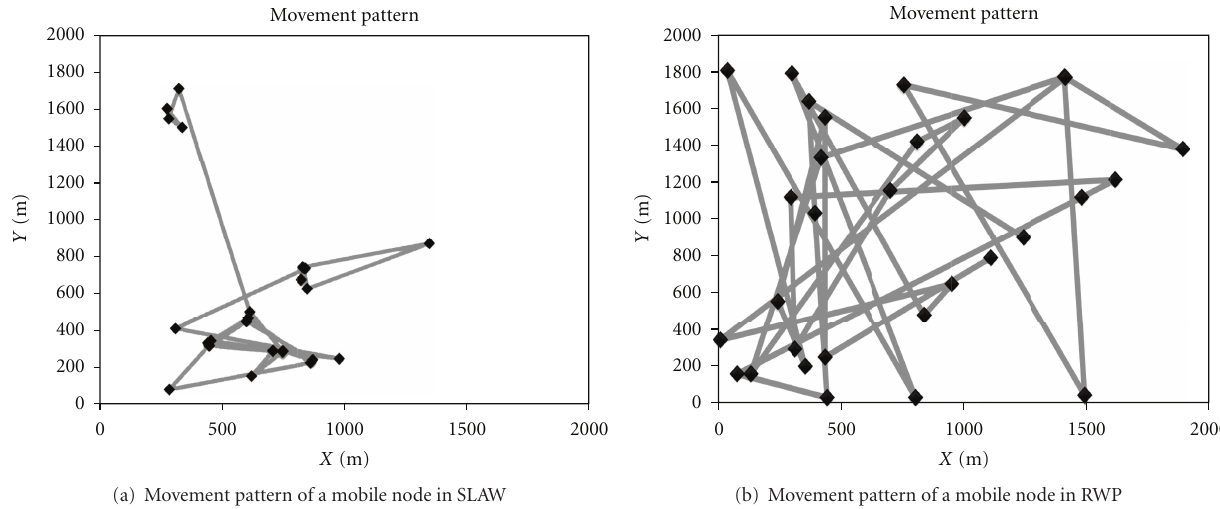
Figure 3: Example initial distributions of mobile nodes in SLAW and RWP.